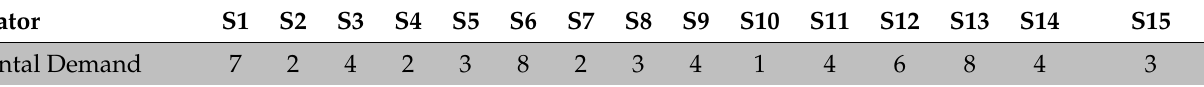
Table 4. NASA-TLX test questions with subject wise score selection.